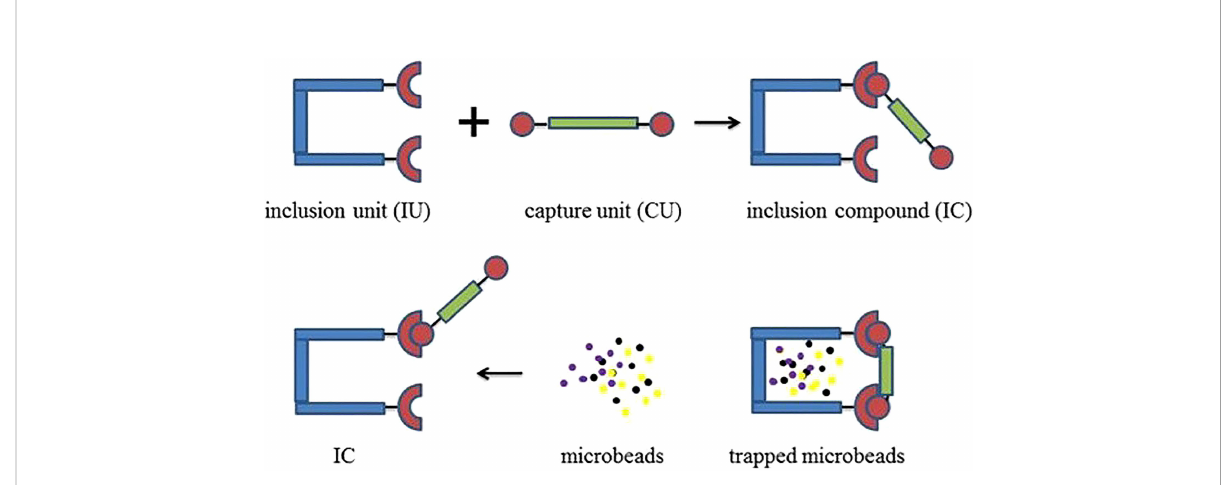
FIGURE 8 Schematic showing the capture mechanism of hydrophobic stressors (Imprinted from (Herbort and Schuhen,